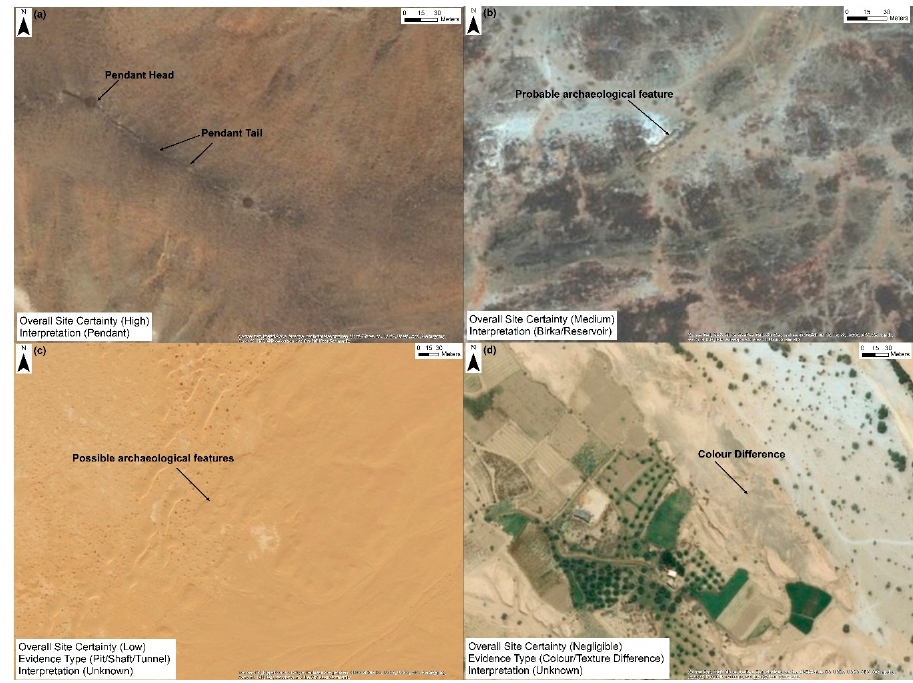
Figure 5. Different examples of site types and archaeological certainty. All sites have been